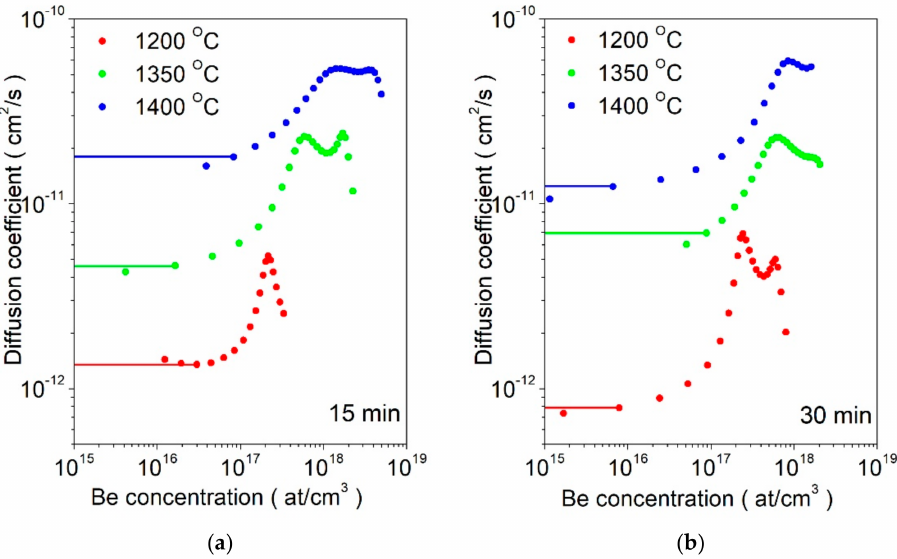
Figure 7. Matano analysis of Be depth profiles according to Equation (3) for samples annealed for: ( a ) 15 min and ( b ) 30 min; lines indicate the di ff usion coe ffi cients for low concentration of Be; two peaks are visible for high Be concentrations; they may result from the departure from the Matano analysis at the initial Be